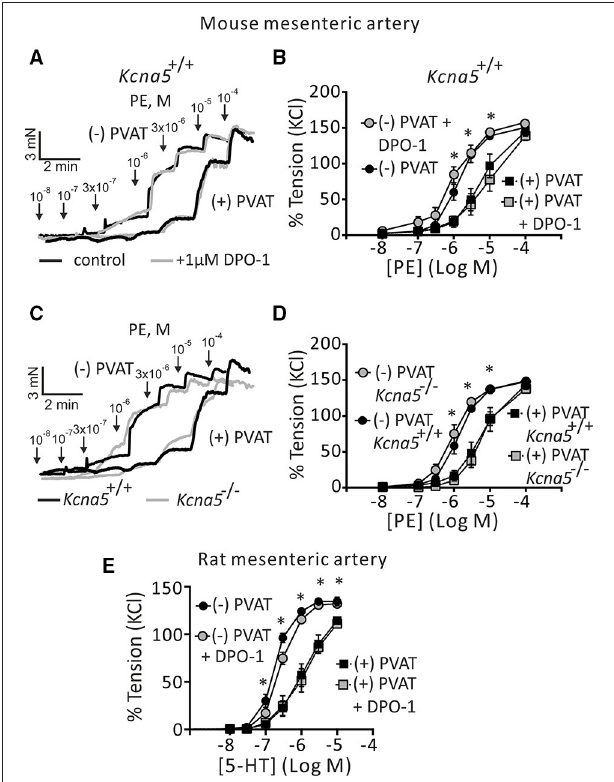
FIGURE 1 | Effects of pharmacological blockade and genetic deletion of K V 1.5 channels on regulation of arterial tone by perivascular adipose tissue (PVAT), phenylephrine (PE), and serotonin (5-HT). (A) Original traces showing the effects of 1 µ M DPO-1 on PE-induced contractions in ( − ) PVAT and ( + ) PVAT mesenteric artery rings compared with control rings without DPO-1. (B) Concentration-response relationships for PE-induced contractions in Kcna5 + / + ( + ) PVAT ( n = 8) or ( − ) PVAT ( n = 9) mesenteric arteries in the absence of DPO-1 or in Kcna5 + / + ( + ) PVAT ( n =